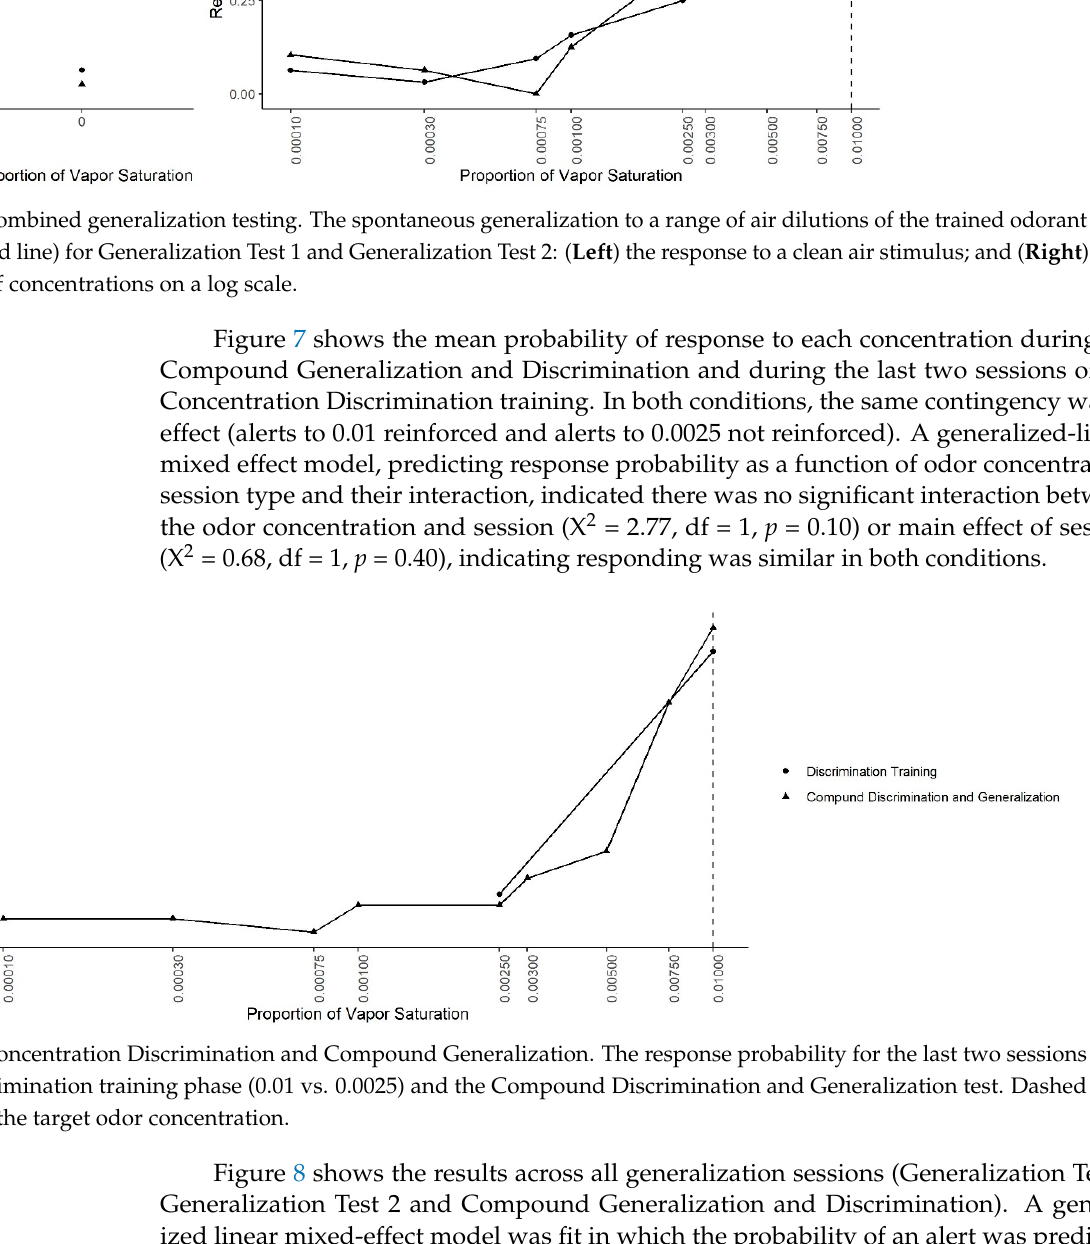
Figure 7. Concentration Discrimination and Compound Generalization . The response probability for the last two sessions of the discrimination training phase (0.01 vs. 0.0025) and the Compound Discrimination and Generalization test. Dashed line shows the target odor concentration.